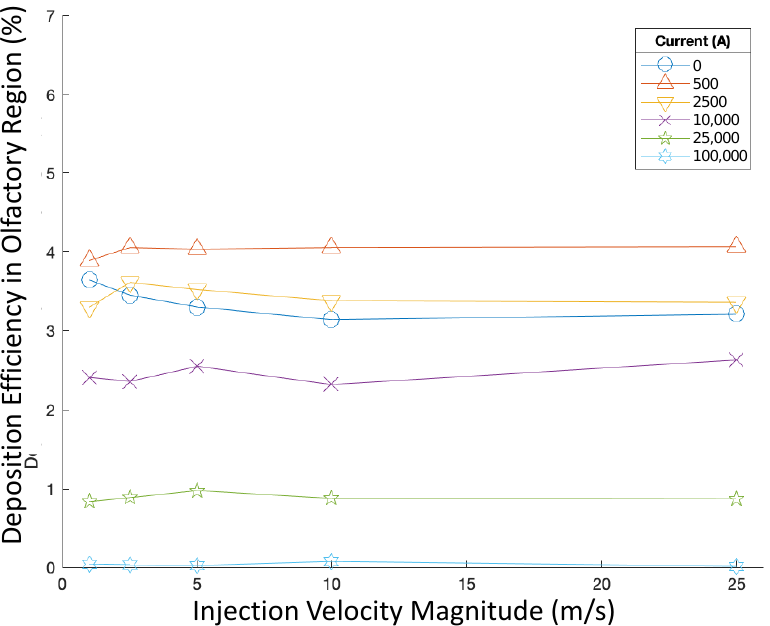
Figure 9. Deposition efficiencies in varying magnetic fields for different injection velocity magnitudes of targeted